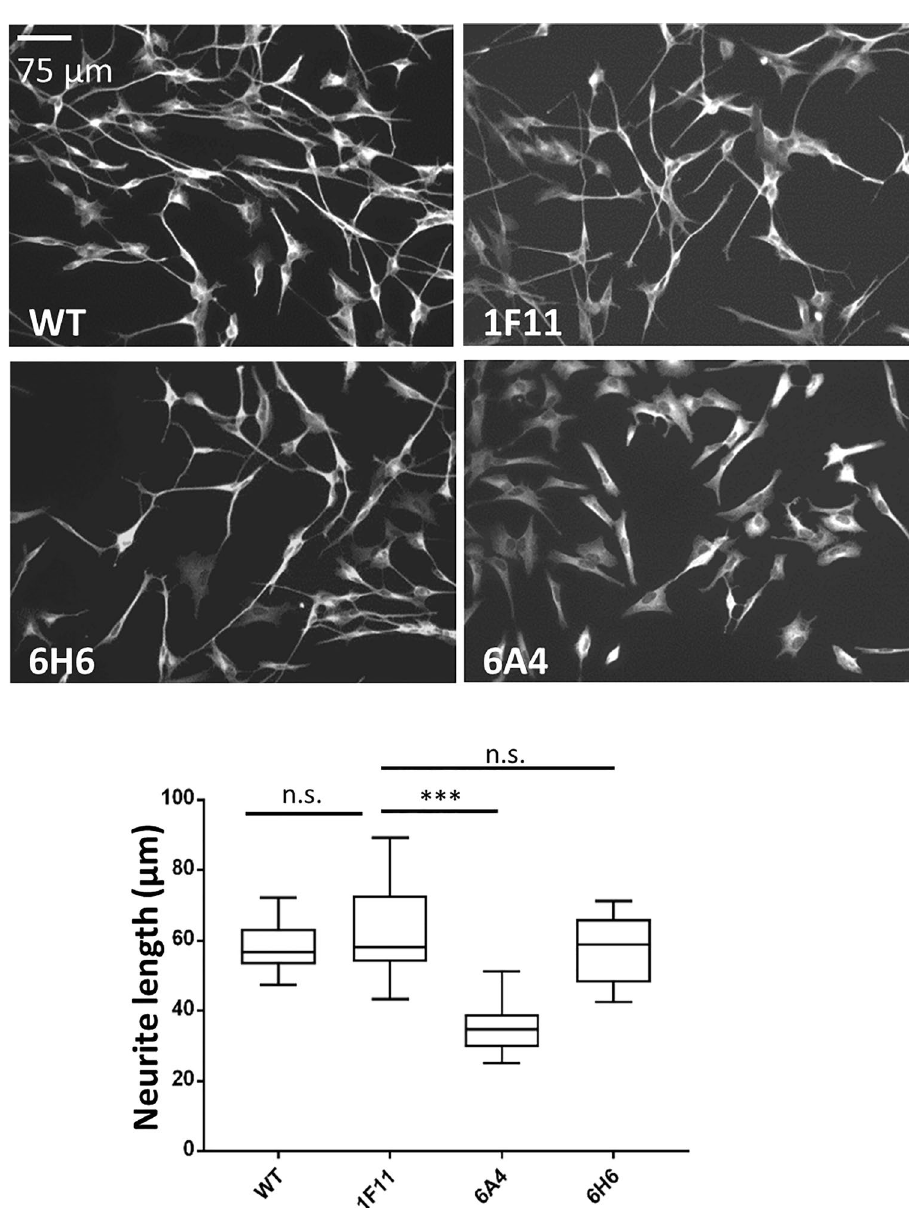
Figure 3. Analysis of cell morphology. Immunofluorescence microscopy was carried out with β3-Tubulin and the length of neurites after 4 days of differentiation was measured, revealing significantly shorter neurites for the cell line with compound heterozygous SHANK2 mutation (6A4) in comparison to the control 1F11. n = 3 experiments, one-way ANOVA (F = 31.1, P < 0.0001), corrected P-values from Dunnett’s test (6A4 P < 0.0001, 6H6 P = 0.36, WT P = 0.48). No difference was observed between the two control lines WT and 1F11. Data were presented in box plots. ***P ≤